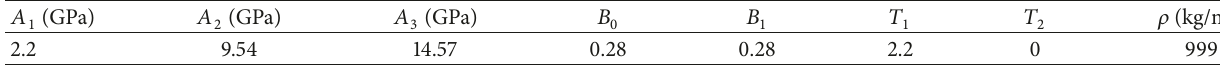
Table 3: Polynomial EoS for water.